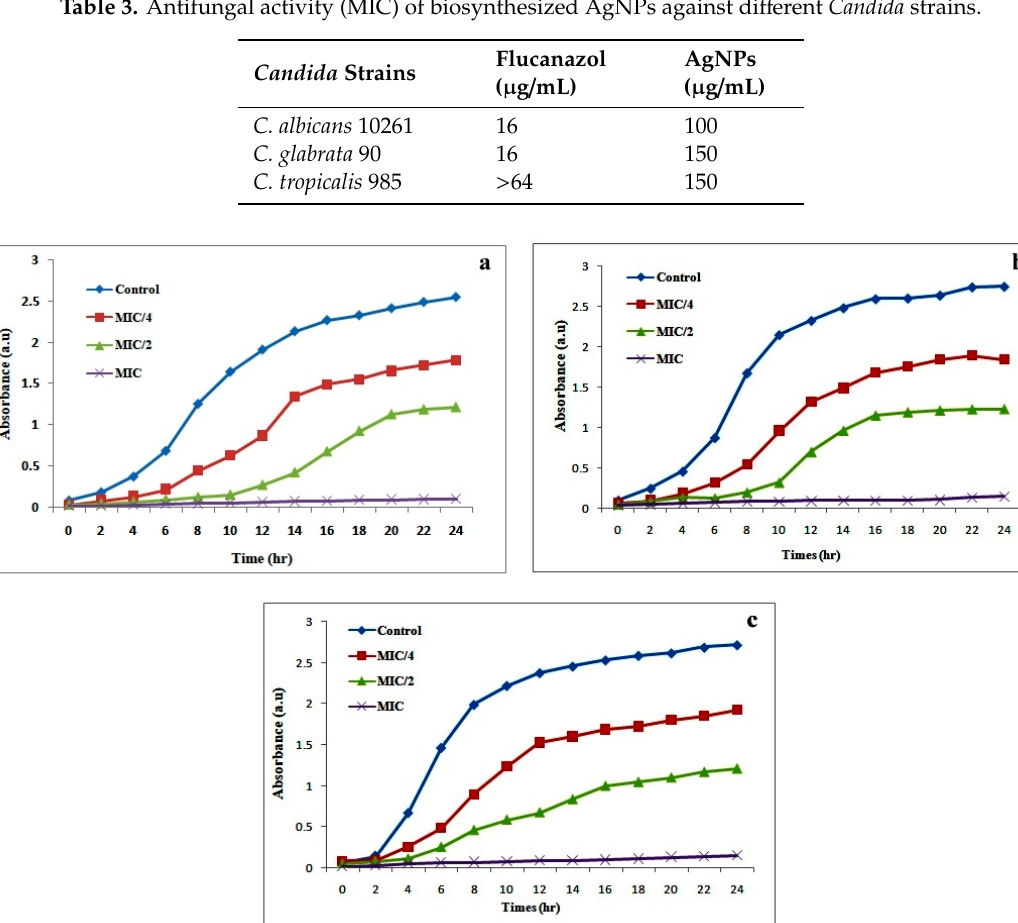
Figure 8. Growth curves pattern of C. albicans ( a ), C. glabrata ( b ), and C. tropicalis ( c ) in the presence of di ff erent concentration of biosynthesized AgNPs.